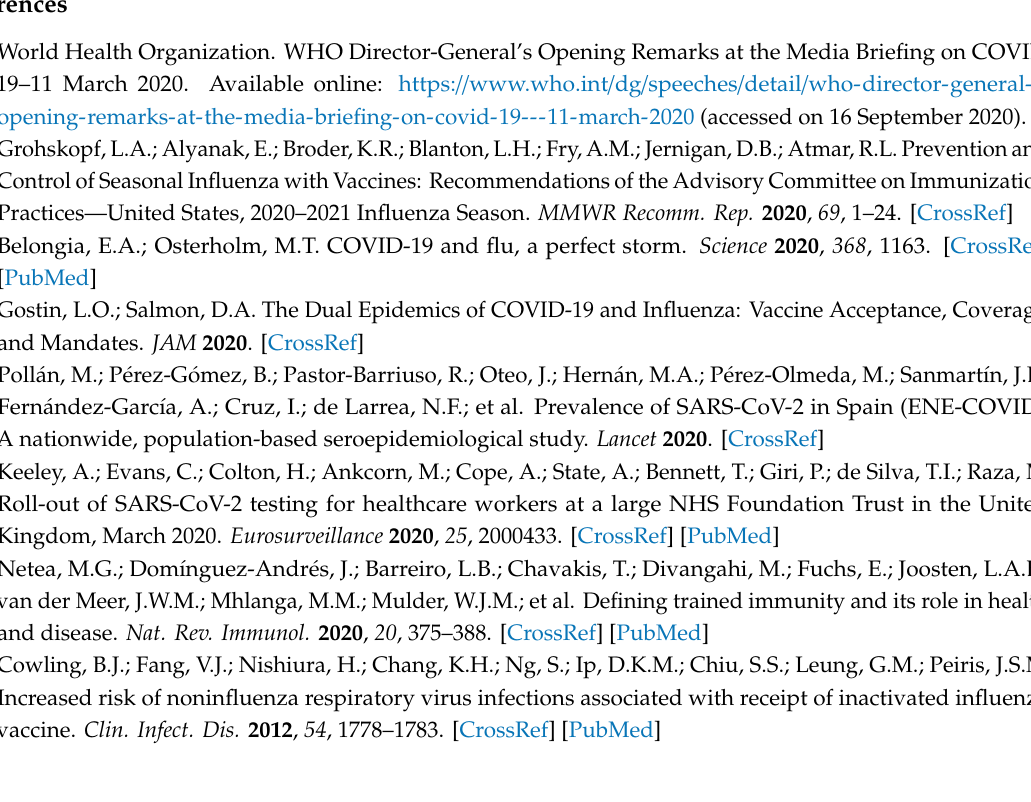
Table S1: Proportion of health workers who were tested for SARS-CoV-2, Table S2: Proportion of health workers who were tested for SARS-CoV-2 according to the type of